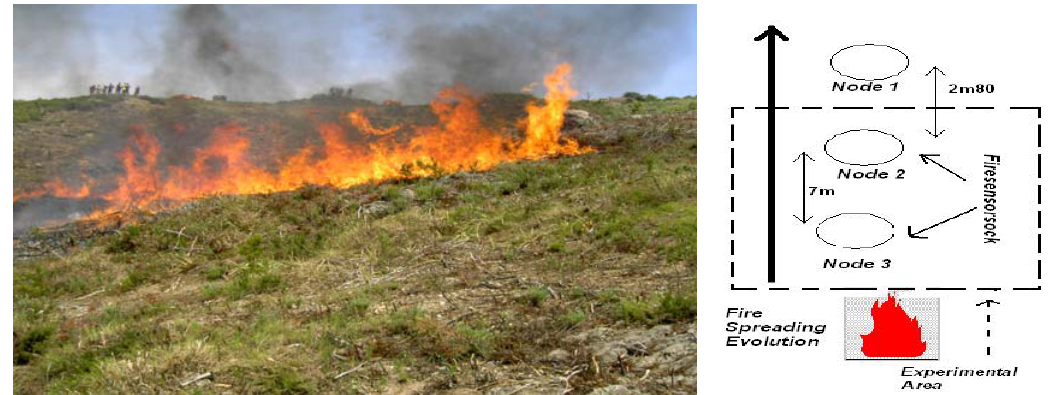
Figure 3. MICA2 1 st GEN Experimental Area.